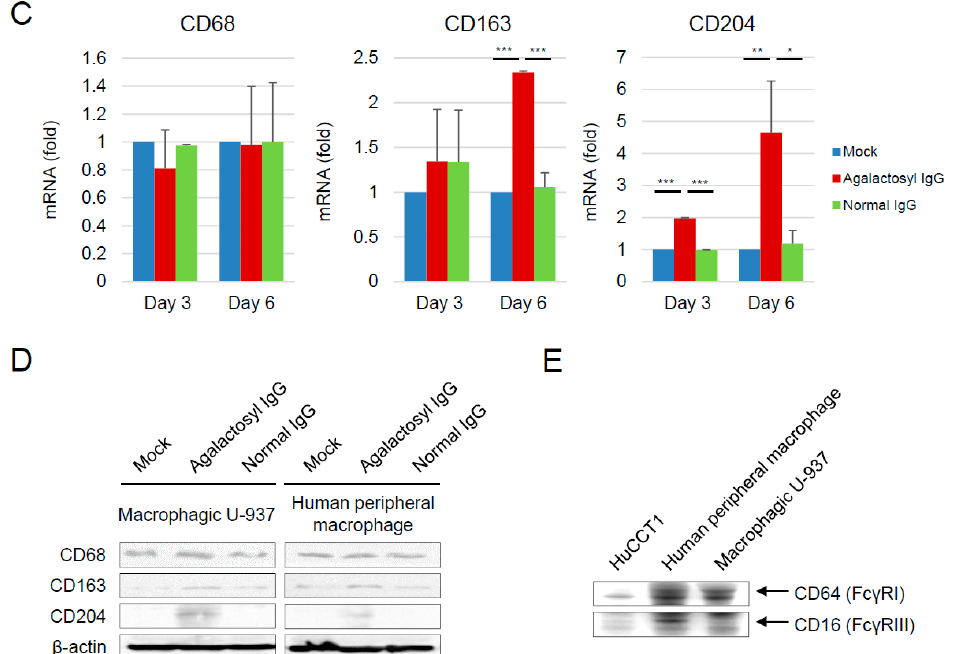
Figure 2. Induction of tumor-associated macrophage by agalactosylated IgG. ( A ) Numbers of CD163+ macrophages in the tumor foci of cholangiocarcinoma in patients with different tumor grades (left panel), with or without tumor metastasis (middle panel), or with different IgG 1 -G0F level (right panel) are shown in Tukey box-and-whisker plots. A P -value in the left panel is obtained from the Kruskal–Wallis test. P -values in the middle and right panels are obtained from Mann–Whitney U tests. ( B ) A schematic representation of the depletion of terminal sialic acid and galactose moieties on serum IgG using α 2-3,6,8 neuraminidase and β 1-4 galactosidase S, respectively. The proportion of each glycoform on normal or galactose-and-sialic acid-removed (asialyl-agalactosyl) IgG 1 and IgG 2 are shown. ( C ) Messenger RNA levels of the macrophage marker CD68 and tumor-associated macrophage markers CD163 and CD204 in U-937 cells after treatments with 10 ng/mL of phorbol 12-myristate 13-acetate for 2 days and 10 mg/mL of IgG (blue bar, mock; red bar, agalactosyl IgG; green bar, normal serum IgG) for another 3 or 6 days, are shown in bar graphs as means with standard deviations. Results are obtained from three independent experiments. p -values are obtained from one- way analysis of variance with Scheffé post hoc tests. Immunoblotting assays to detect protein levels of ( D ) CD68, CD163, and CD204 at day 6 post-treatment and ( E ) CD64 (Fc γ RI) and CD16 (Fc γ RIII) in macrophagic U-937 cells and human peripheral macrophages are shown. (* p < 0.05, ** p < 0.01, *** p < 0.001). Abbreviations: HPF, high-power field.